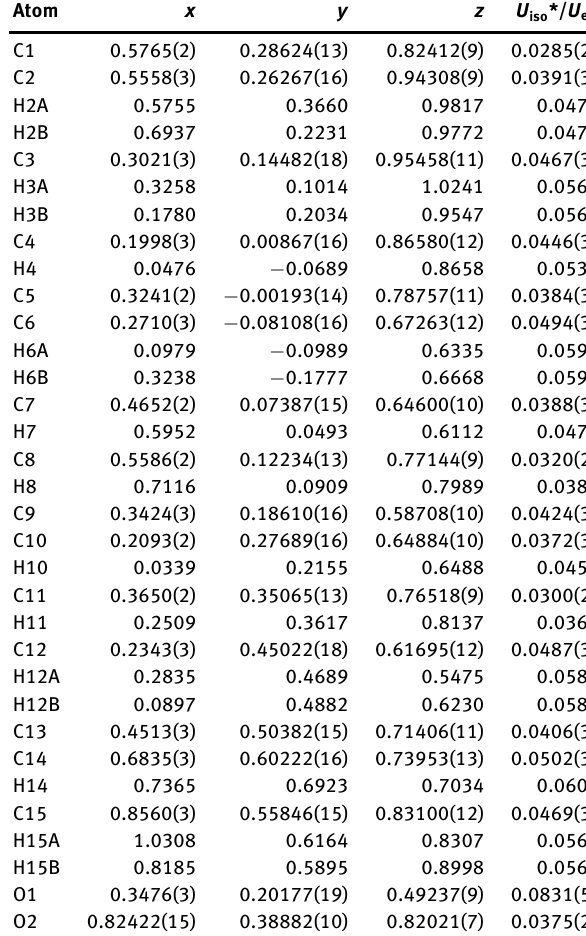
Table 2: Fractional atomic coordinates and isotropic or equivalent isotropic displacement parameters (Å 2